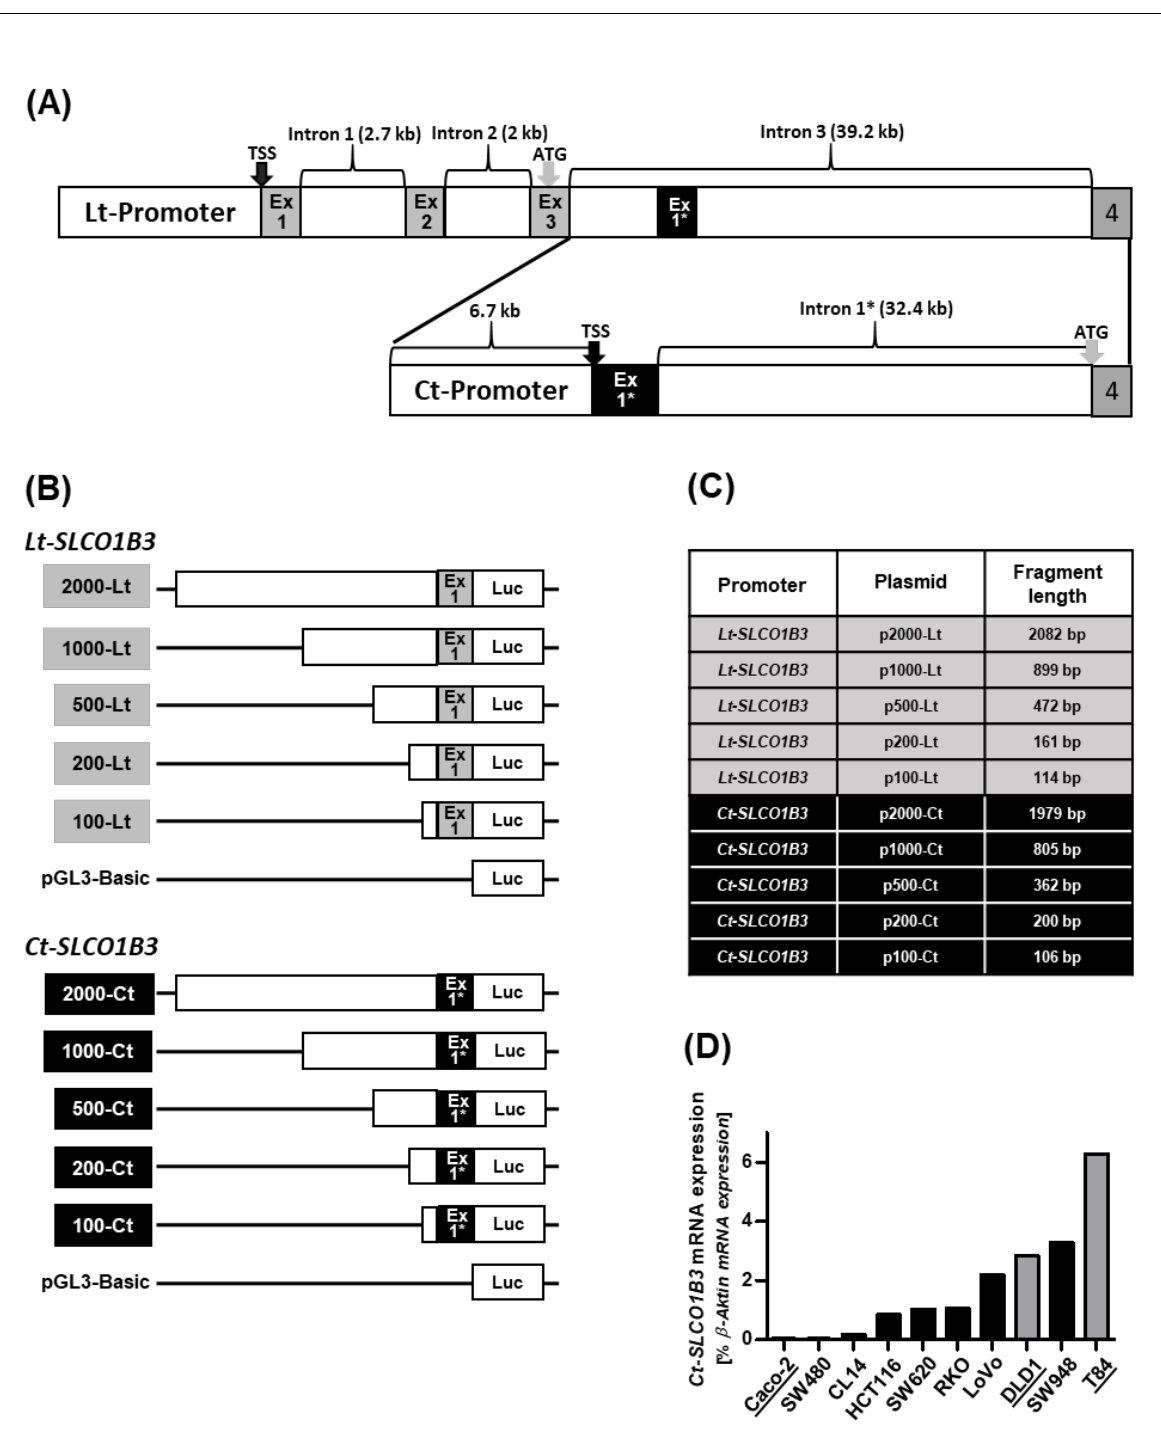
Figure 1. ( A ) Schematic overview of the upstream promoter regions of the Lt- and Ct-SLCO1B3 genes. ( B ) For each promoter region, several reporter gene constructs were cloned with varying length (between 2000 bp and 100 bp) of the respective upstream region of the Lt- and Ct-SLCO1B3 gene. The fragment lengths shown in ( C ) indicate the final length of the cloned fragments (without the respective exon overlap). ( D ) qRT-PCR analysis of Ct-SLCO1B3 mRNA expression in ten colorectal carcinoma cell lines. Underlined names and grey boxes mark three cell lines used for further reporter gene analysis. TSS = transcriptional start site; ATG indicates the respective start codon; Ex1, Ex2, Ex3 = Lt-SLCO1B3 exclusive exons; Ex1* = the alternatively spliced first exon of Ct-SLCO1B3 ; Intron 1* = first intron of the Ct-SLCO1B3 gene; LUC = firefly luciferase gene within the pGL3-Basic vector.